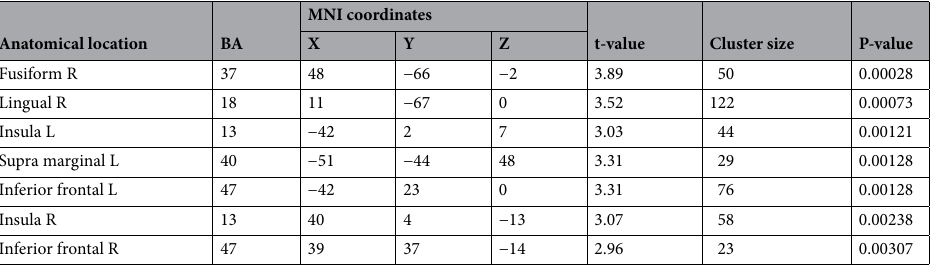
Table 6. Brain regions with significant mean diffusivity (MD) changes. The table reports each brain region found significant in a time-by-group repeated measures ANOVA comparing the two groups (HBOT N = 8, sham N = 8). The results are in specific Montreal Neurological Institute (MNI) coordinates; X sagittal, Y coronal, Z axial, refer to MNI. BA Brodmann area. All coordinates emerged at a threshold of p < 0.005, uncorrected. Minimum cluster size: 20; R right, L